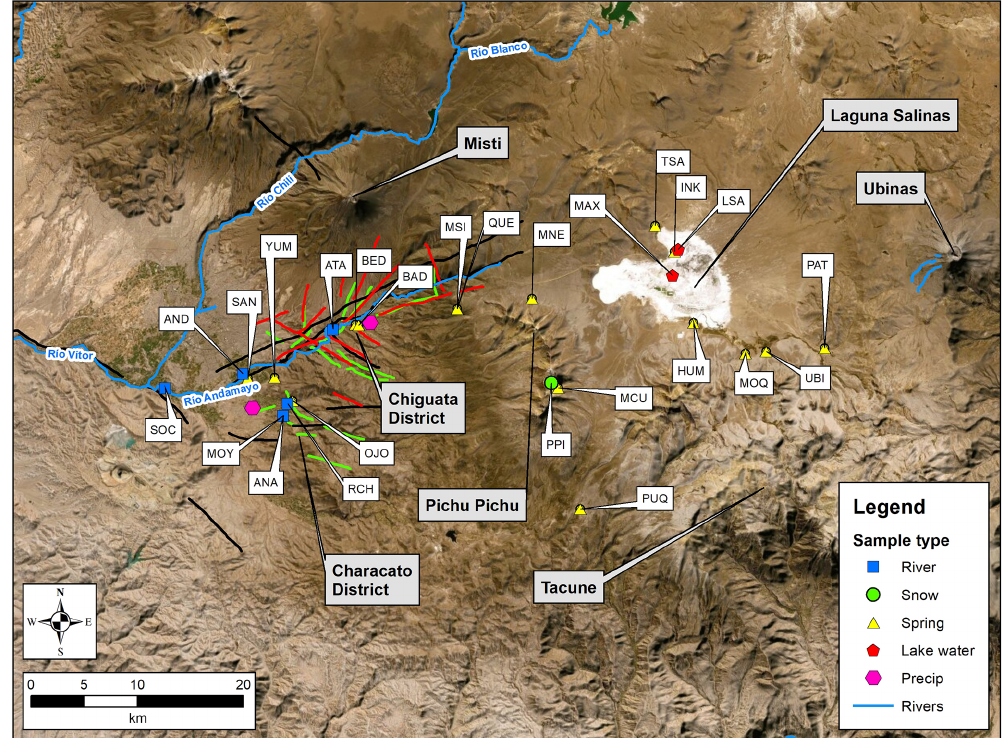
Figure 2. Map of the study area, sampling locations, and faults identified. The different types of water are indicated by different symbols in the legend. Green lines are faults identified in Bernard et al. (2019); black lines are faults identified in Lebti et al. (2006); and red lines are faults identified in Thouret et al. (2001). The Río Andamayo is fault-bounded (black lines running parallel to the river). The La Bedoya (BED) and El Badén (BAD) springs are located in the Chiguata District. The springs Sabandia (SAN), Yumina (YUM), Ojo de Characato (OJO), and Santa Ana (ANA) are located in the Characato District. Blue lines are rivers. (credit: Emily E.